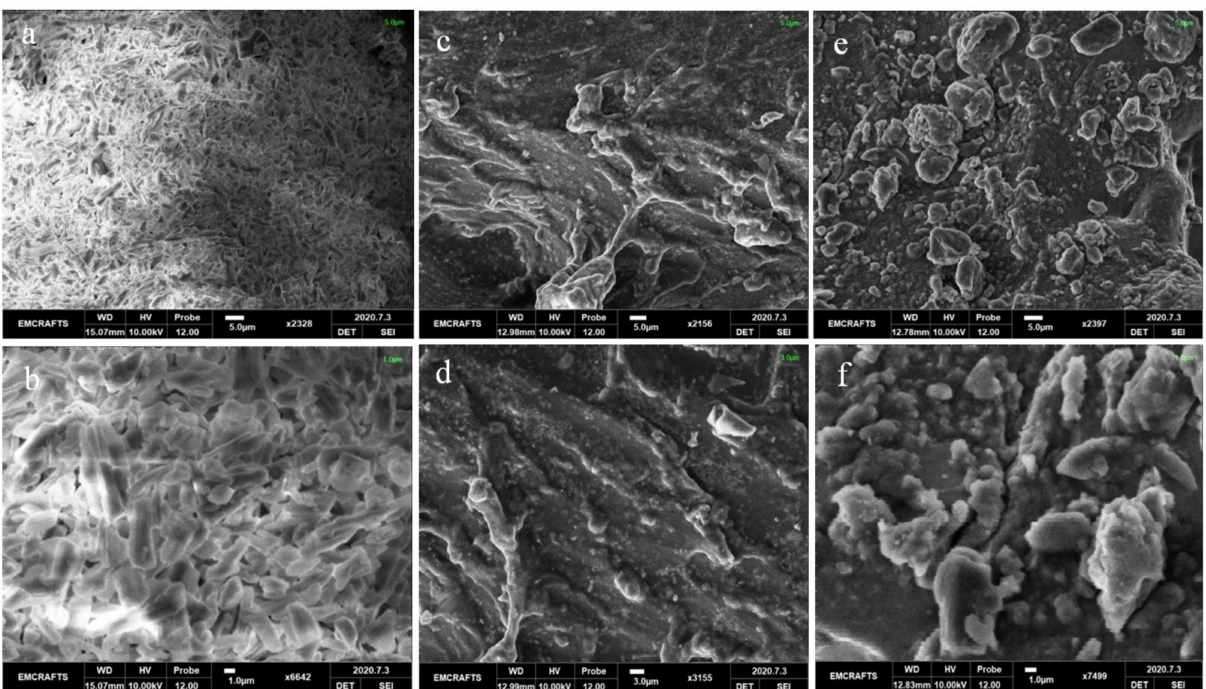
Figure 10. Surface morphology of DSP ( a , b ), blank ( c , d ) and loaded ( e , f ) semi-IPN hydrogels as observed under